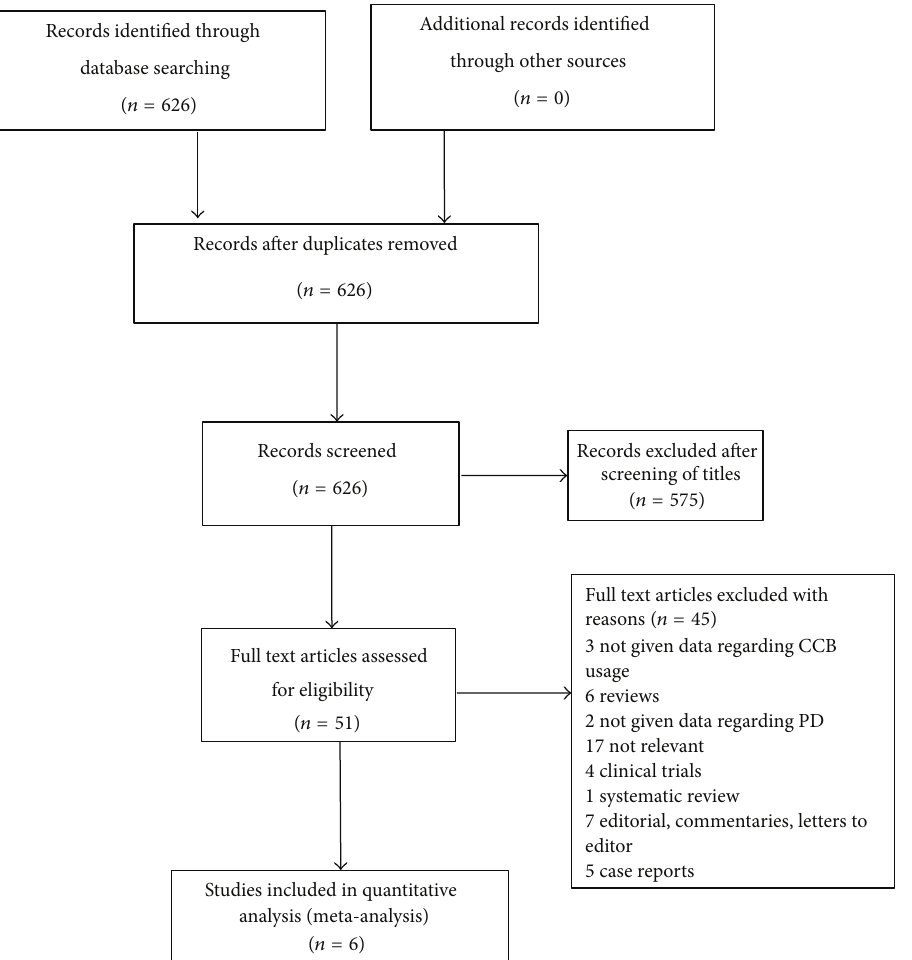
Figure 1: Flowchart representing the selection process.